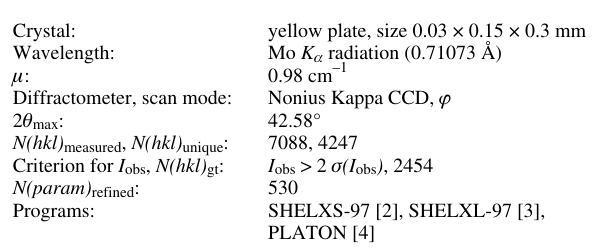
Table 1. Data collection and handling.